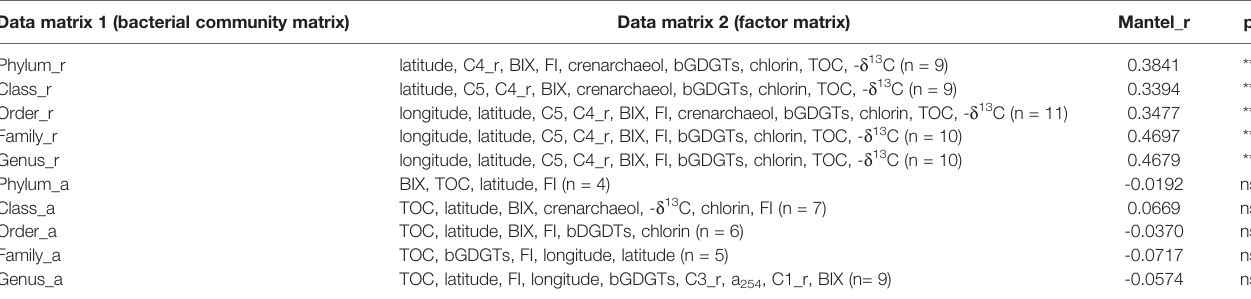
TABLE 1 | Mantel test between bacterial community compositions and signi fi cant factors. Data matrix 1 (bacterial community matrix) Data matrix 2 (factor